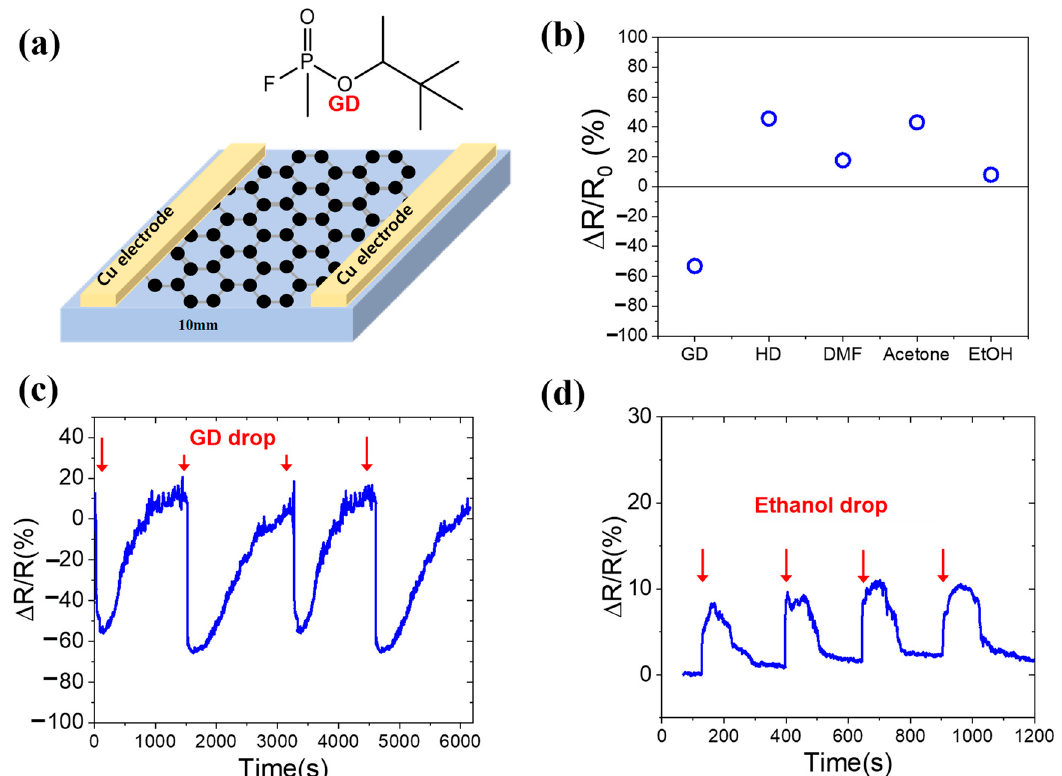
Figure 7. Graphene e-fabric based chemical sensor for detecting chemical warfare agent. ( a ) schematic of the graphene fabric sensor, ( b ) resistance response ( ∆ R/R) of graphene fabric sensor, ( c ) time-dependent resistance response ( ∆ R/R) toward liquid GD droplet (2 µ L), and ( d ) time-dependent resistance response ( ∆ R/R) toward ethanol droplet.